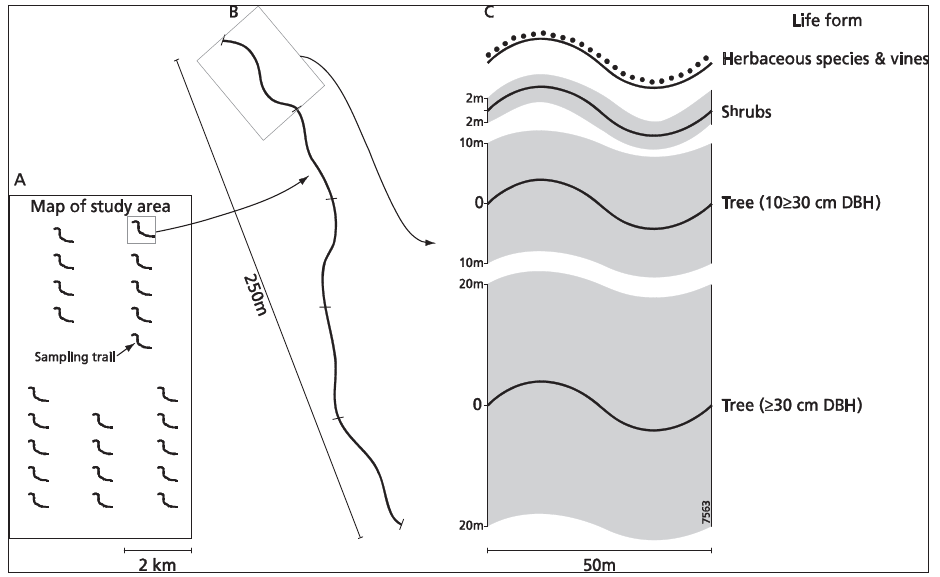
Fig. 3. Sampling scheme modified from the RAPELD method (see Magnusson et al., 2005). (A) 23 transects (sampling trail) are regularly spaced over the site; (B) each transect is placed at the same elevation level and divided in five sampling transect each of 50m length. (C) Sampling along the transect. Herbaceous species: point samples at regular interval along the transect centre line. Shrubs, large-sized trees and medium-sized trees: exhaustive sampling in the indicated zone. The tree size category is based on diameter of the trunk at breast height